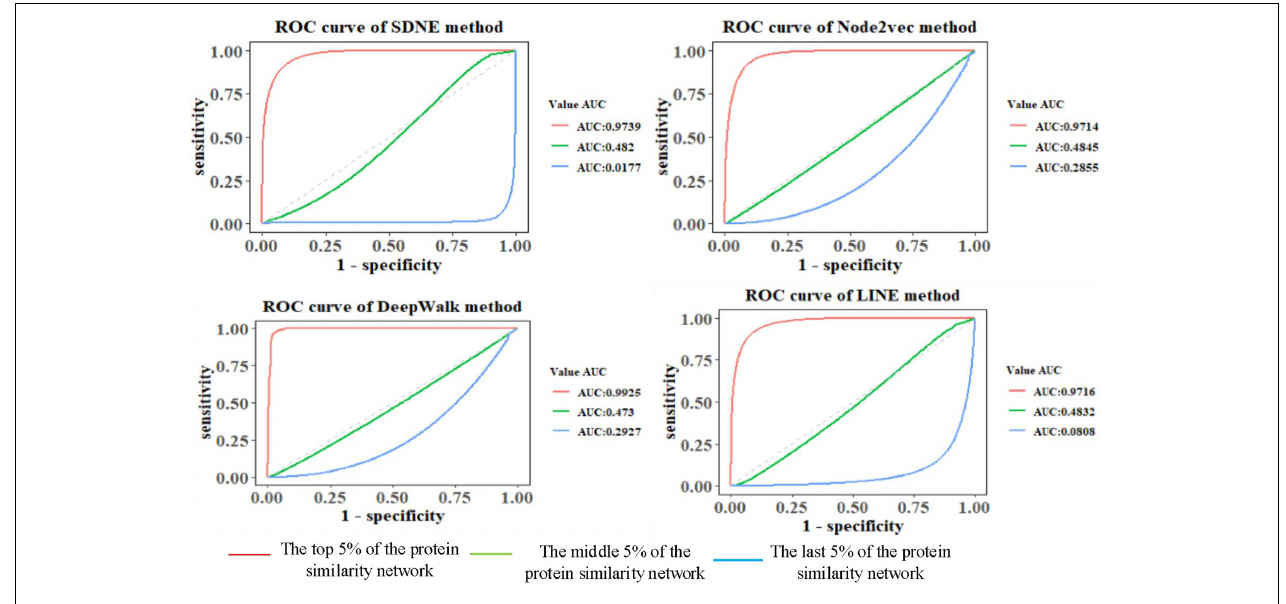
FIGURE 5 | Comparison of prediction results of Human protein similarity networks.